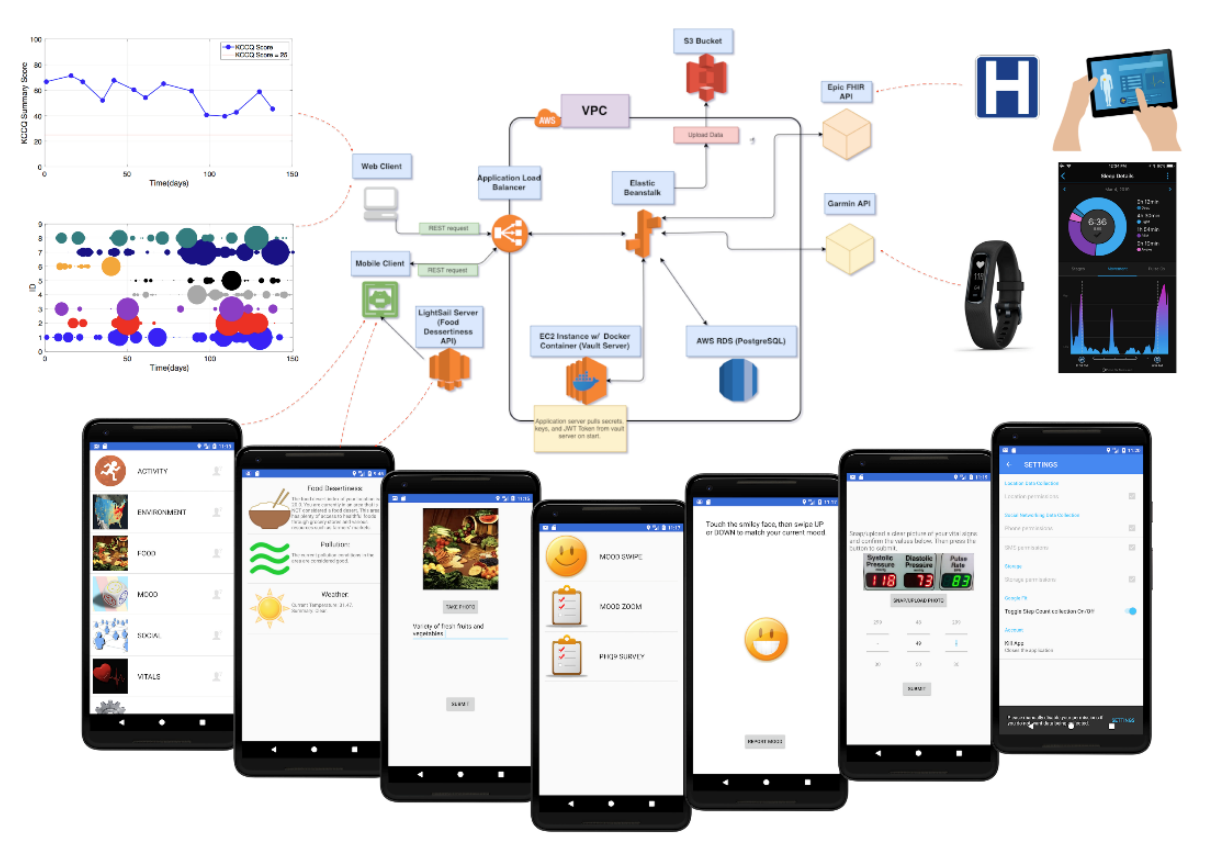
Figure 1. Schematic of app-cloud framework for securely collecting health and activity data. API: application programming interface; AWS: Amazon Web Services; EC2: Amazon Elastic Compute Cloud; FHIR: Fast Healthcare Interoperability Resources; JWT: JSON Web Token; REST: